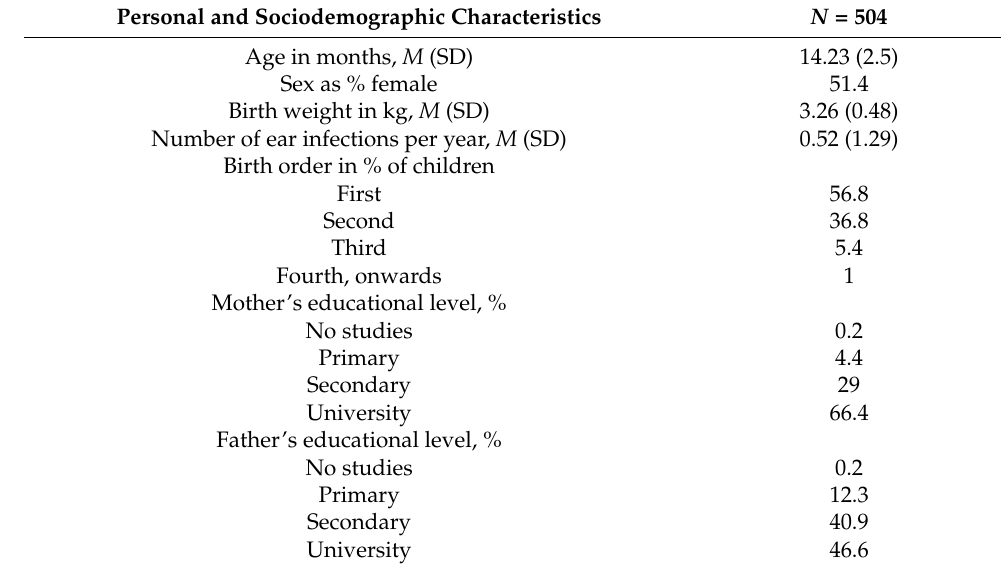
Table 1. Main descriptive data of the